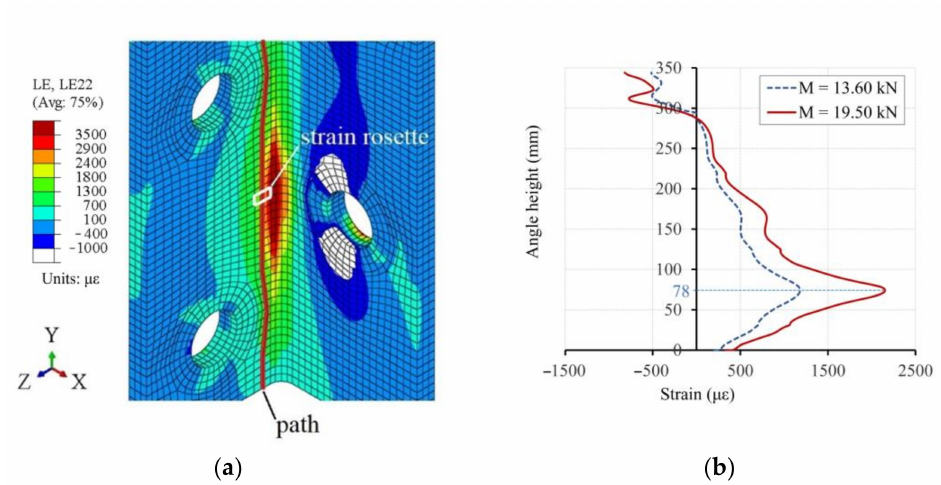
Figure 15. ( a ) Definition of longitudinal path along the height of connecting angle; ( b ) transversal logarithmic strain (LE22) along the height of connecting